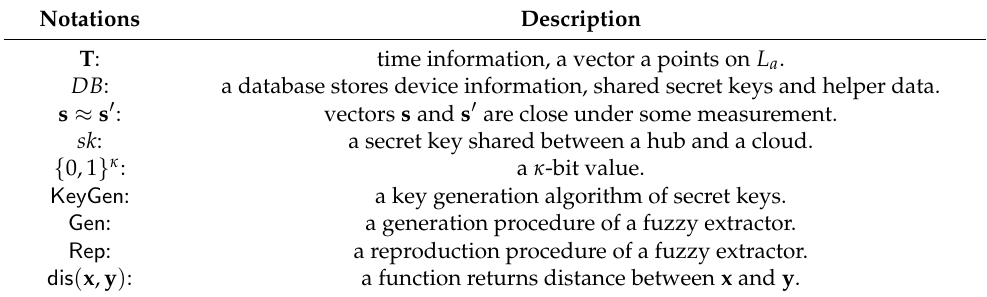
Table 1. Notations of the